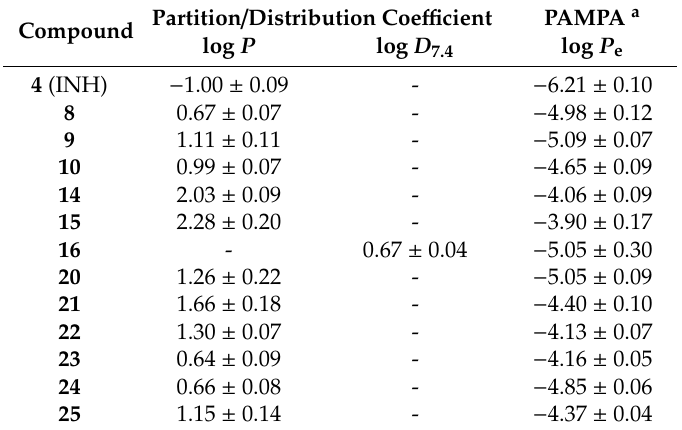
Table 3. Measured lipophilicity and permeations of compounds 4 , 8 – 10 , 14 – 16 , and 20 – 25 . Partition / Distribution Coe ffi cient PAMPA a Compound log D